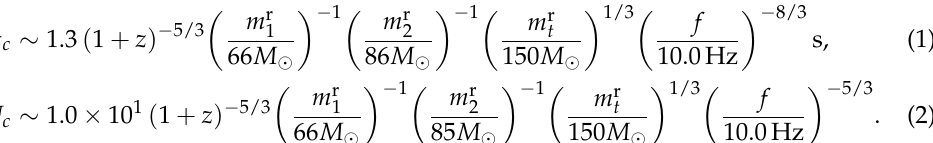
85 + 21 − 14 2 66 + 17 − 18 1 − 0.62 0.73 + 0.24 −